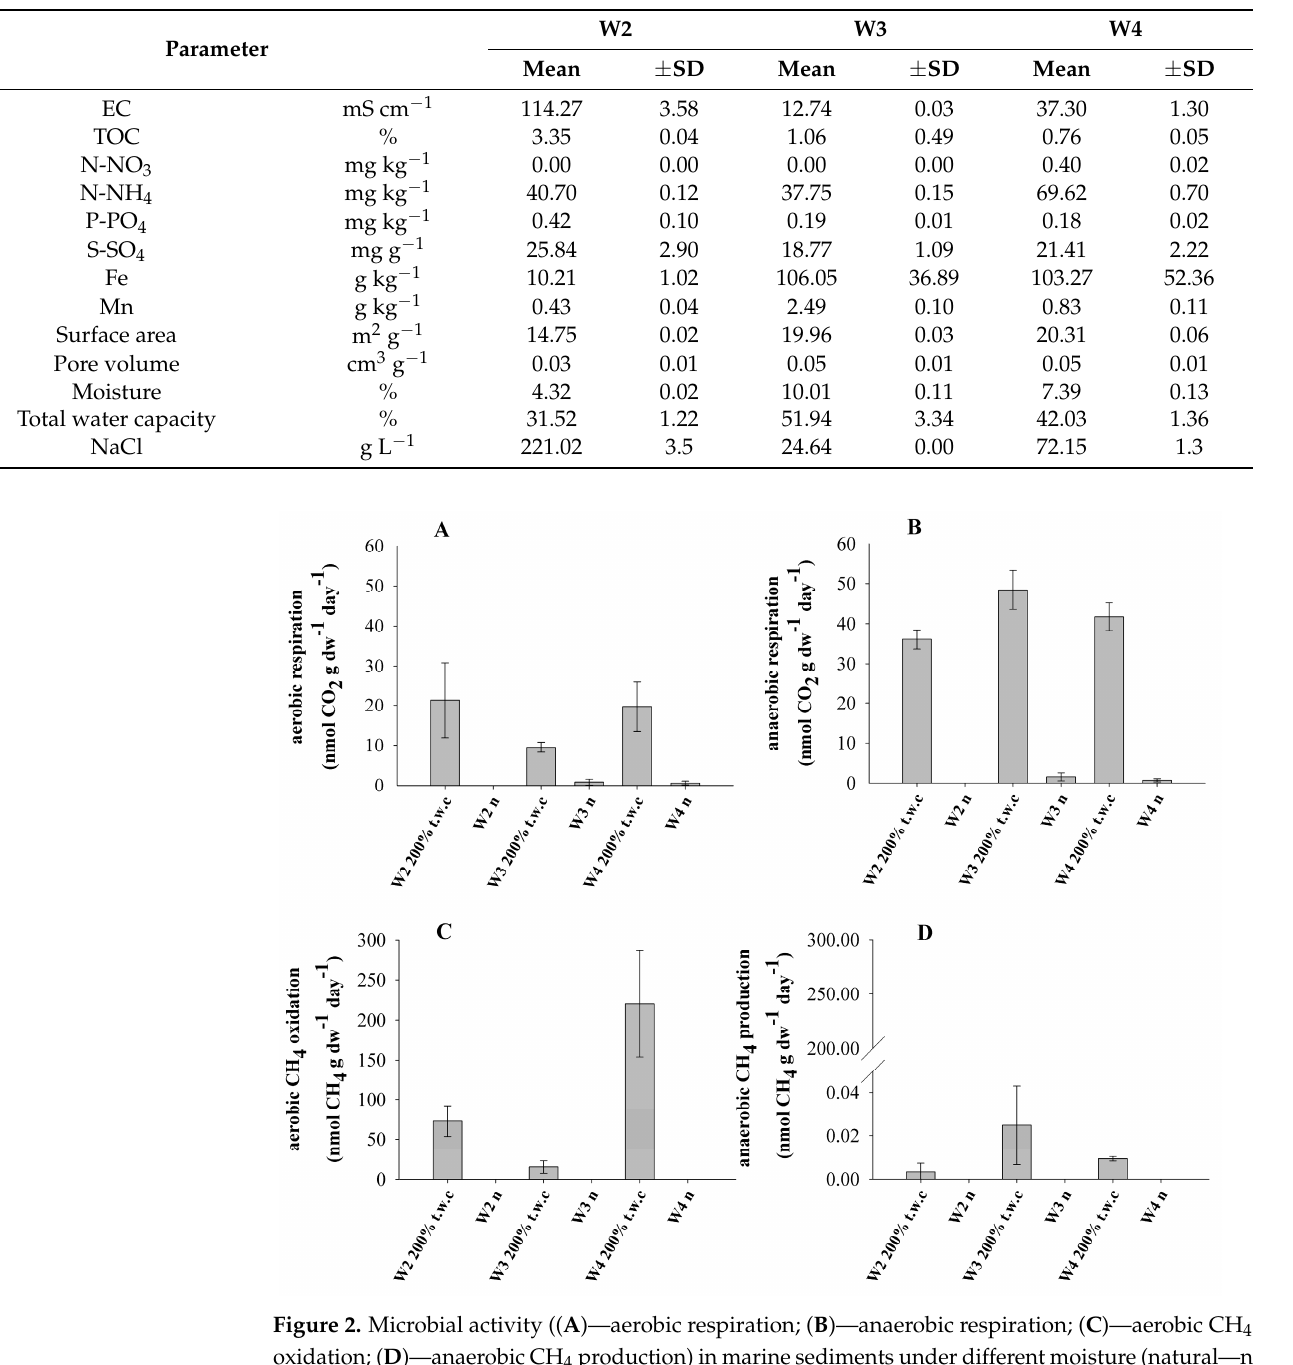
Table 3. Physico-chemical properties of the Wieliczka Formation sediments (adapted from St˛epniewska et al. [19]).